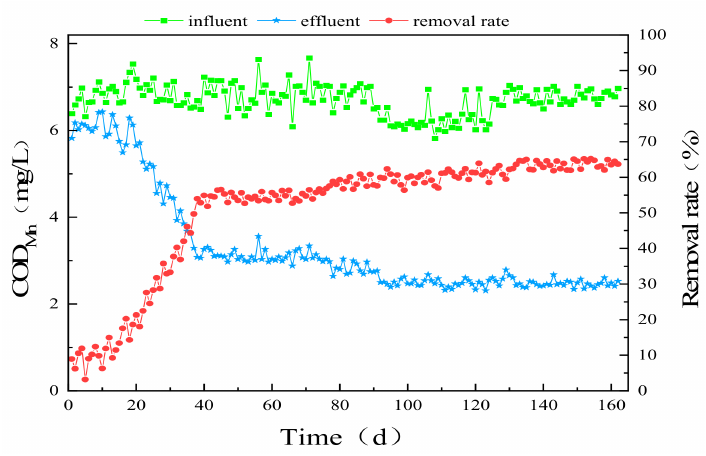
Figure 3. COD Mn use reduction in aeration biofilter